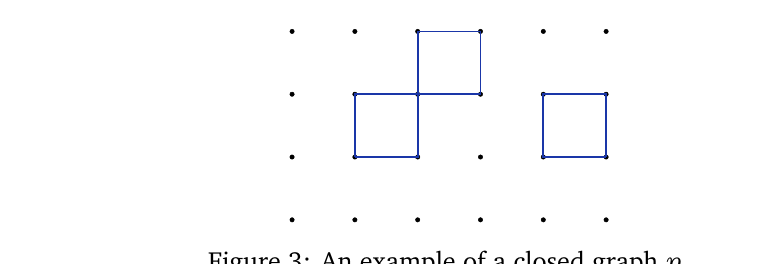
Figure 3: An example of a closed graph η